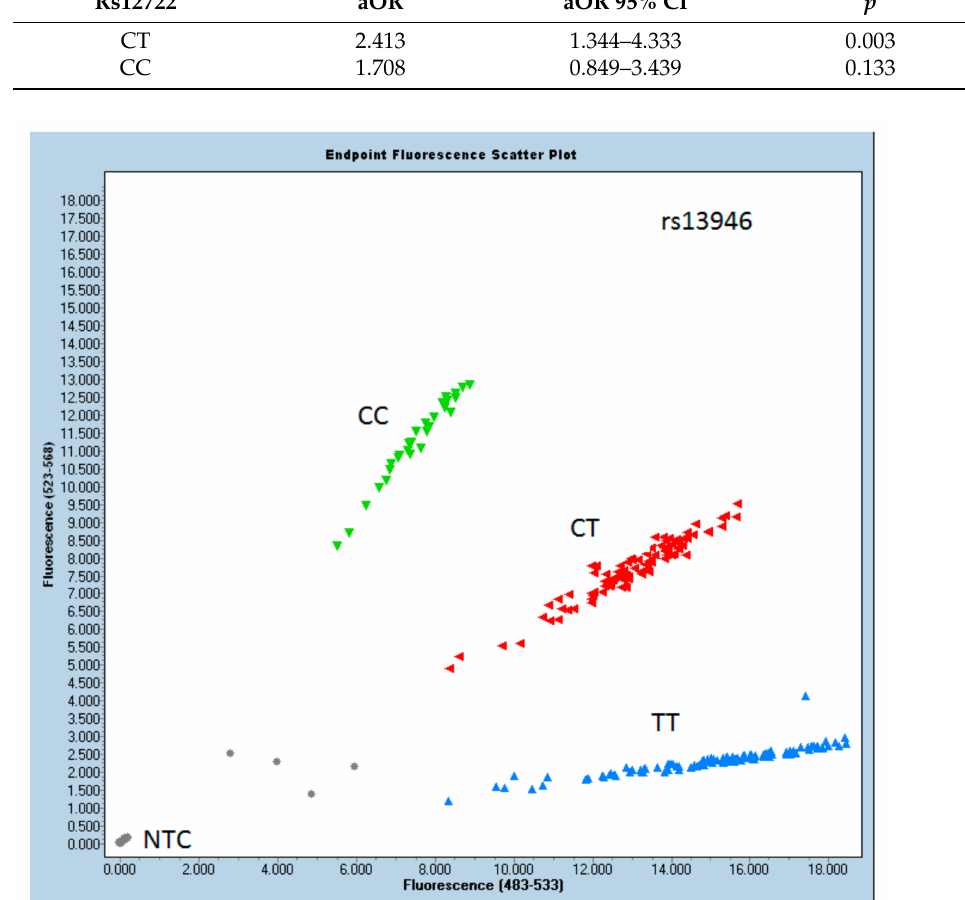
Figure 1. Allelic distribution plot of rs13946 genotypes in the study and control